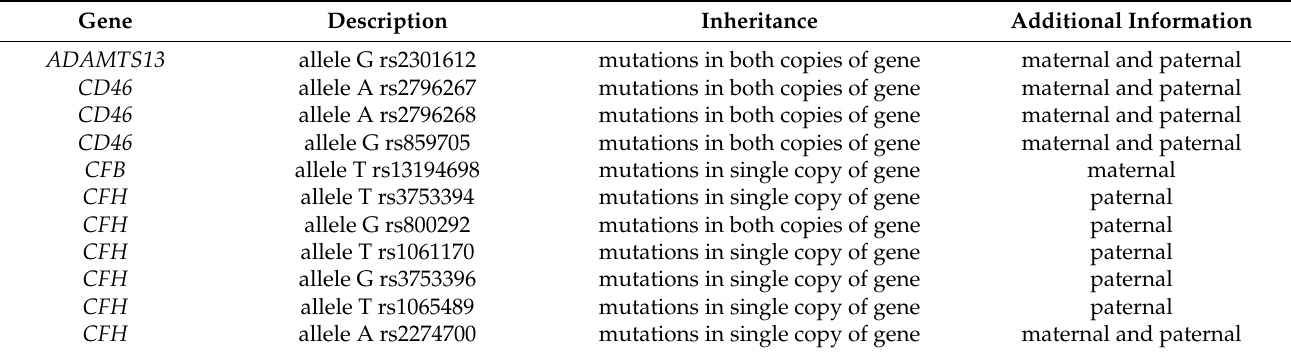
Table 2. Genetic